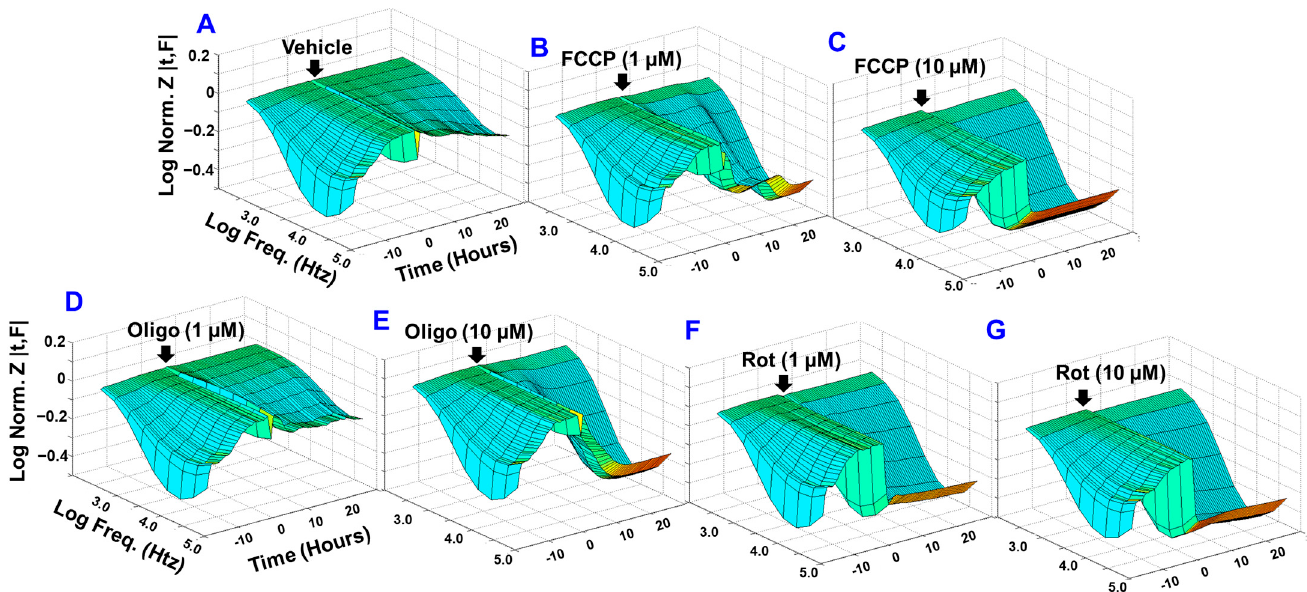
Figure 1. Bioimpedance analysis of the effects of different mitochondrial inhibitors on the barrier function of HRECs using the ECIS technology. Three-dimensional analysis was prepared by plotting the log of normalized impedance ( Y -axis) as a function of both log frequencies of 1 µA alternating current (AC) on the X -axis and time on the Z -axis. HRECs were treated with the vehicle (DMSO; A ) and different concentrations of mitochondrial inhibitors: FCCP (1 and 10 µM; B and C , respectively), oligomycin (Oligo;1 and 10 µM; D and E , respectively), and rotenone (Rot, 1 and 10 µM; F and G , respectively) at the time point when HRECs formed a confluent monolayer. This time was considered to be (t = 0), and its impedance value (Z 0 ) was used to normalize all other impedance measurements (Z t ) by determining the ratio of Z t /Z 0 . Different AC frequencies ranging from 250 to 64,000 Hz were utilized for the real-time impedance measurement. Abbreviations: Z, impedance; Norm, normalized; Freq, frequency; Z t , the impedance at time t; Z 0 , the impedance at time 0. Data shown are representative three-dimensional plots of six independent biological replicates per group.